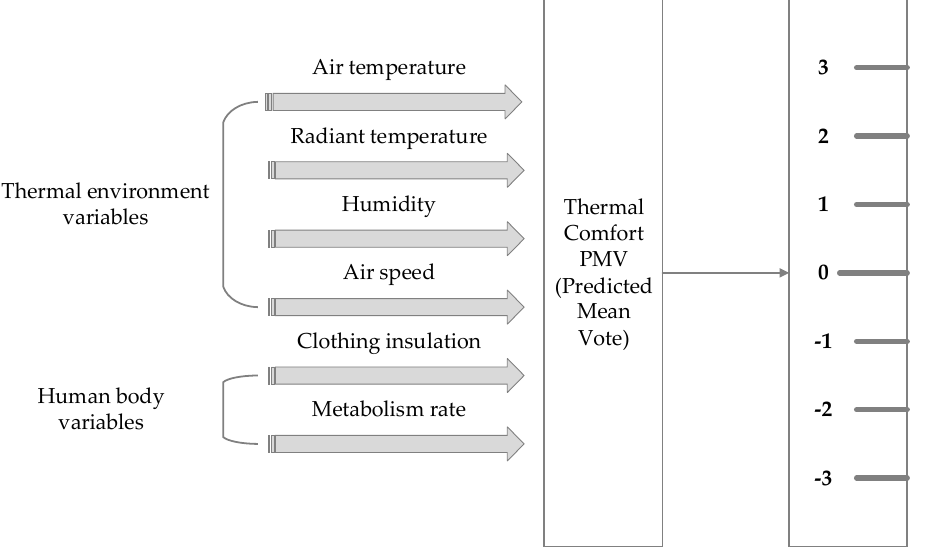
Figure 4. Thermal comfort model dependencies and Figure 4 Thermal comfort model dependencies and scale.